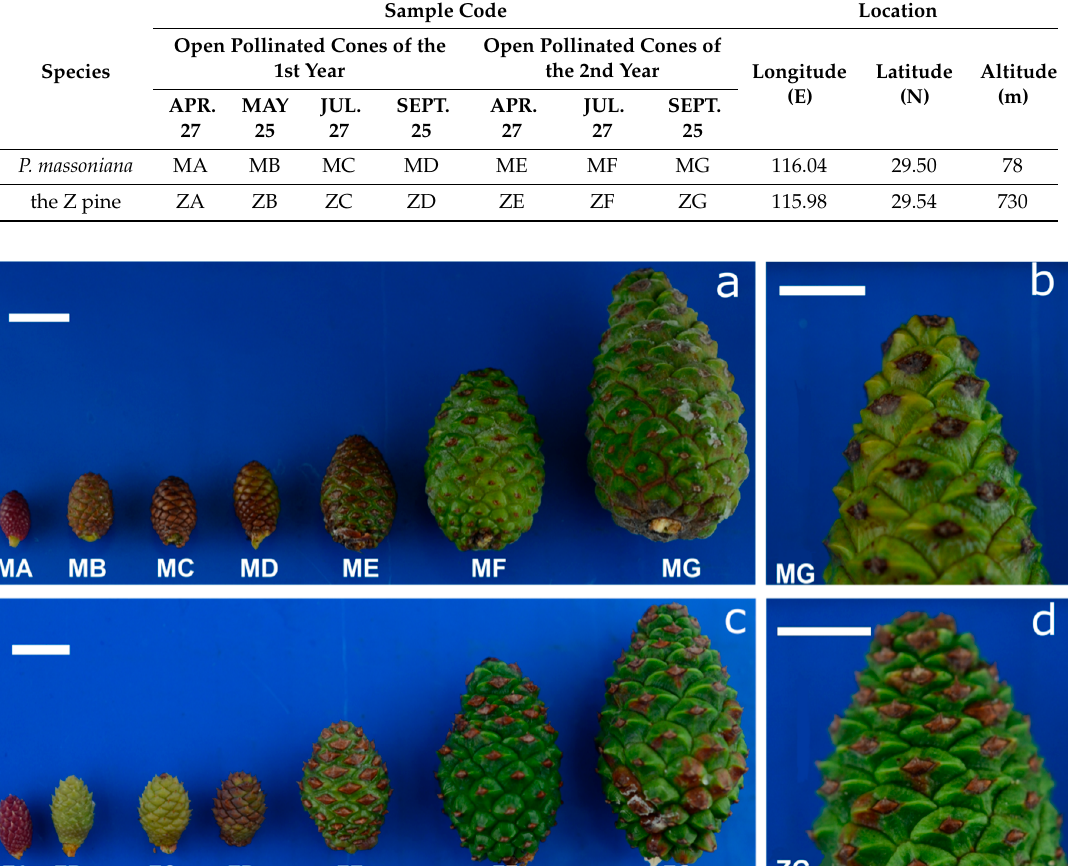
Figure 2. Successively staged pine cones of P. massoniana ( a ) and the Z pine ( c ). Details of mature cones of MG ( b ) and ZG ( d ) stages are shown. The scale shields of P. massoniana are flat or slightly bulged, the transverse ridge is not very obvious, and the scale umbilical has no thorn. The scale shield of the Z pine is bulged, the transverse ridge is obvious, and the scale umbilical is thorny. Codenames for collected cones are explained in Table 1. (Scale = 10 mm.). collected cones are explained in Table 1. (Scale = 10